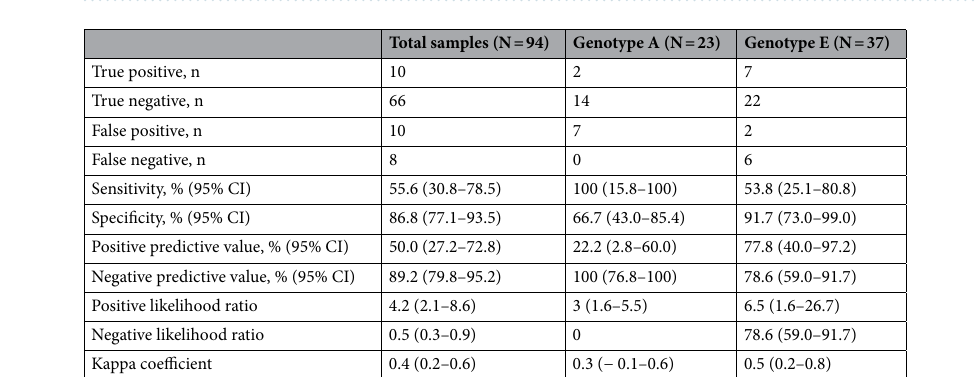
Figure 3. Distribution of HBV DNA by a) HBeAg and b) HBeAg and age among pregnant women in Yako, rural Burkina Faso. The red dots show HBeAg-positive cases, and the blue dots represent HBeAg-negative cases. Numbers on the top of each graph represent the percentage of pregnant women with HBV DNA ≥ 200,000 IU/ mL, the recommended cut-off for antiviral prophylaxis.